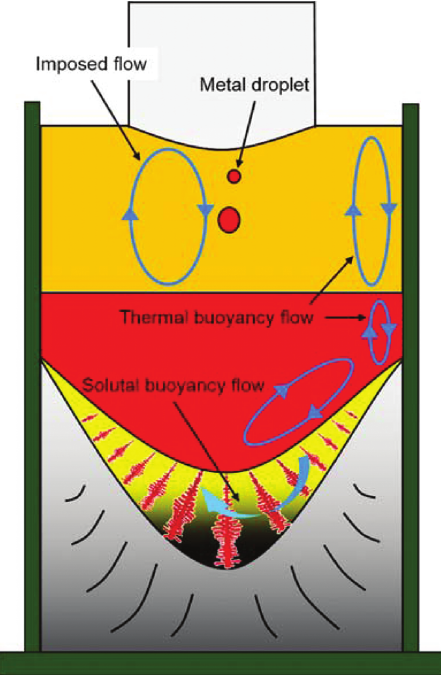
Figure 3: Illustration of the flows of the slag bath and metal pool in the ESR